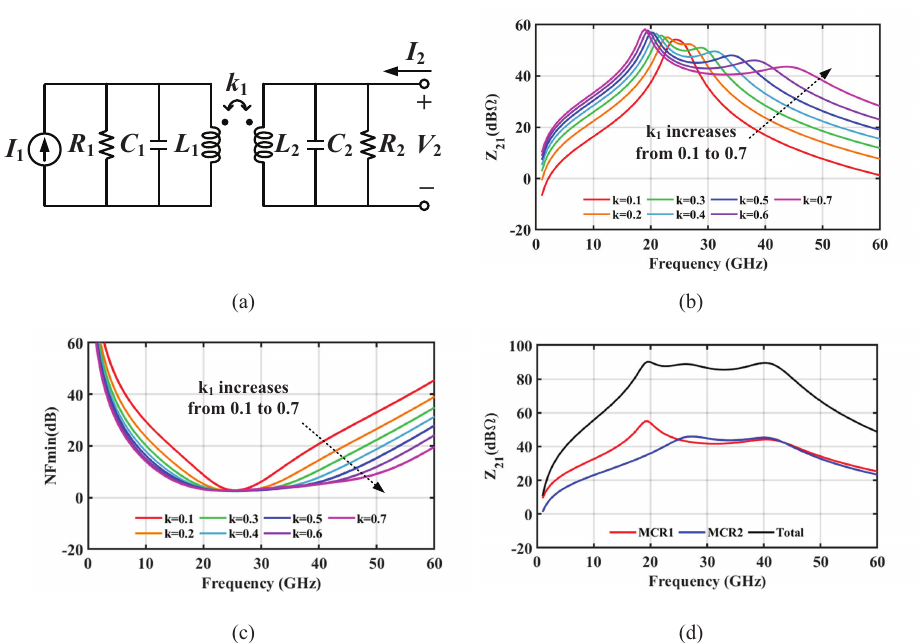
Figure 2. Inter-stage peak-gain distribution technique ( a ) Magnetically coupled resonators (MCRs) schematic. ( b ) the transimpedance responses of the first inter-stage MCR when k 1 varies from 0.1 to 0.7 when the Q is fixed. ( c ) NF min of the first stage with MCR1. ( d ) the transimpedance responses of MCR1, MCR2 and the overall response.